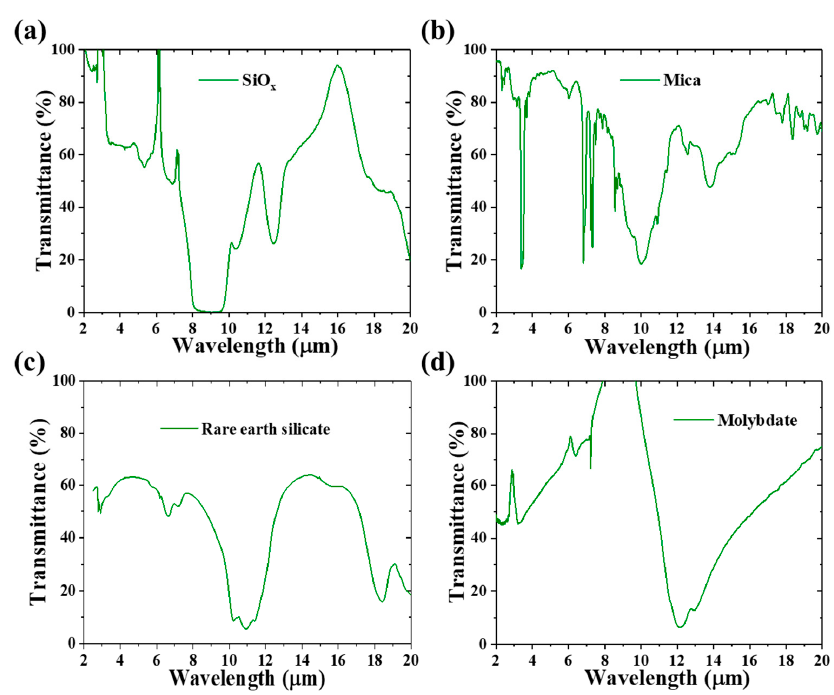
Figure 3. Transmittivity spectra of the functional nanoparticles: ( a ) SiO x ; ( b ) mica; ( c ) rare earth silicate and ( d ) molybdate.